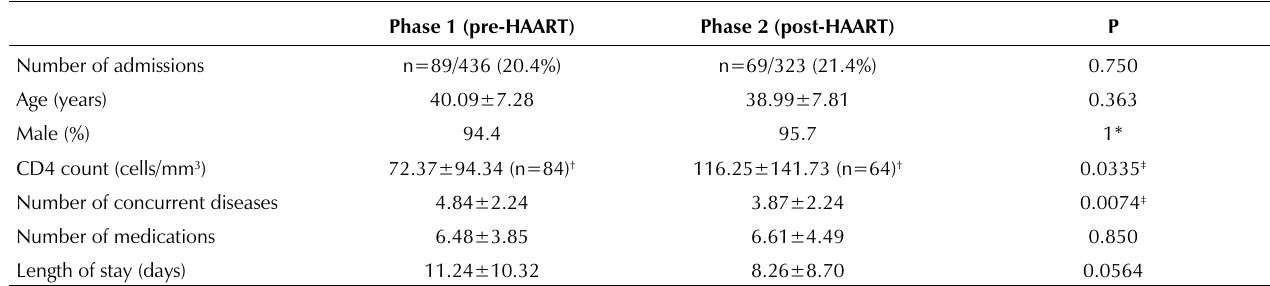
Patient characteristics for admissions with adverse drug reactions of patients before and after the introduction of highly active antiretroviral therapy (HAART) Phase 1 (pre-HAART) Phase 2 (post-HAART)